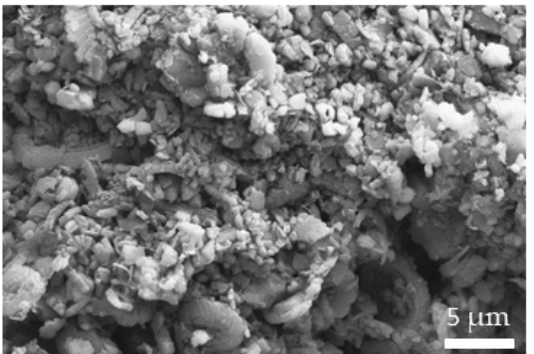
Figure 1. Typical texture of an Upper Cretaceous onshore chalk sample derived from the St. Vaast Formation from Obourg quarry close to Mons (Belgium; sample OBSV 12.3) imaged by SEM showing abundant coccolith rings and high porosity.